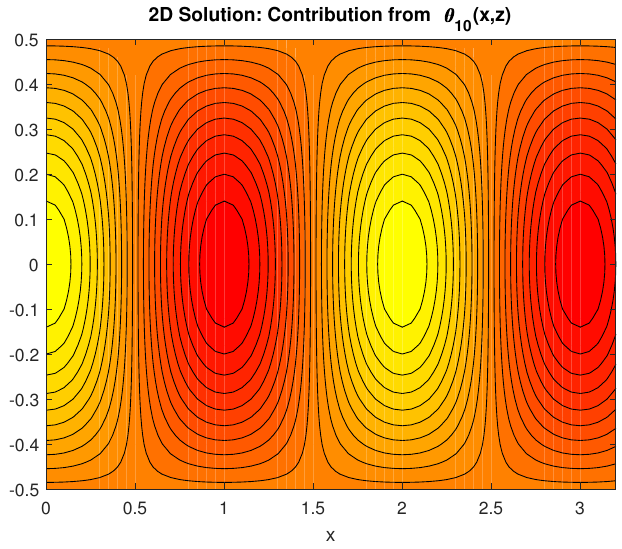
Figure 11. Solution for θ 10 ( x , z )